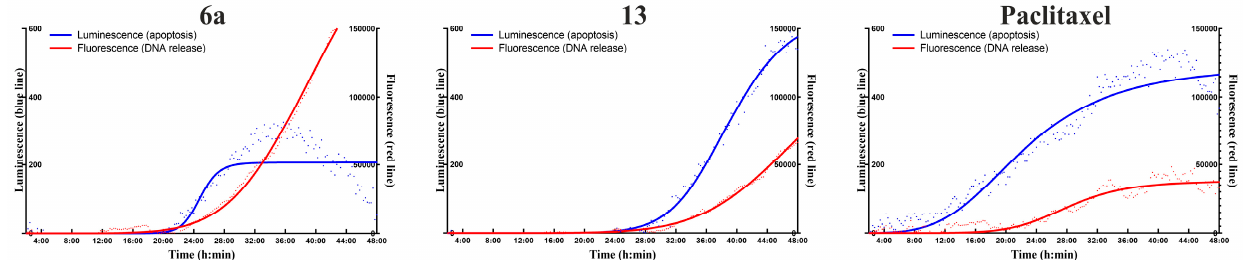
Figure 9. Real-time apoptosis detection in Detroit 562 cells. The cells were treated with the compounds at 2.5 µ M and monitored for 48 h. DNS release as a marker of necrosis provided fluorescent signal (red curve), while annexin V binding as a marker of apoptosis resulted in luminescent signal (blue curve). Intensive increment of luminescent signal, which was followed a few hours later by the appearance of the fluorescent signal, refers to apoptosis. Paclitaxel was used as a positive control of apoptosis. While hybrid 6a resulted in necrotic-like cell death, the effect of hybrid 13 proved to be more apoptotic-like.